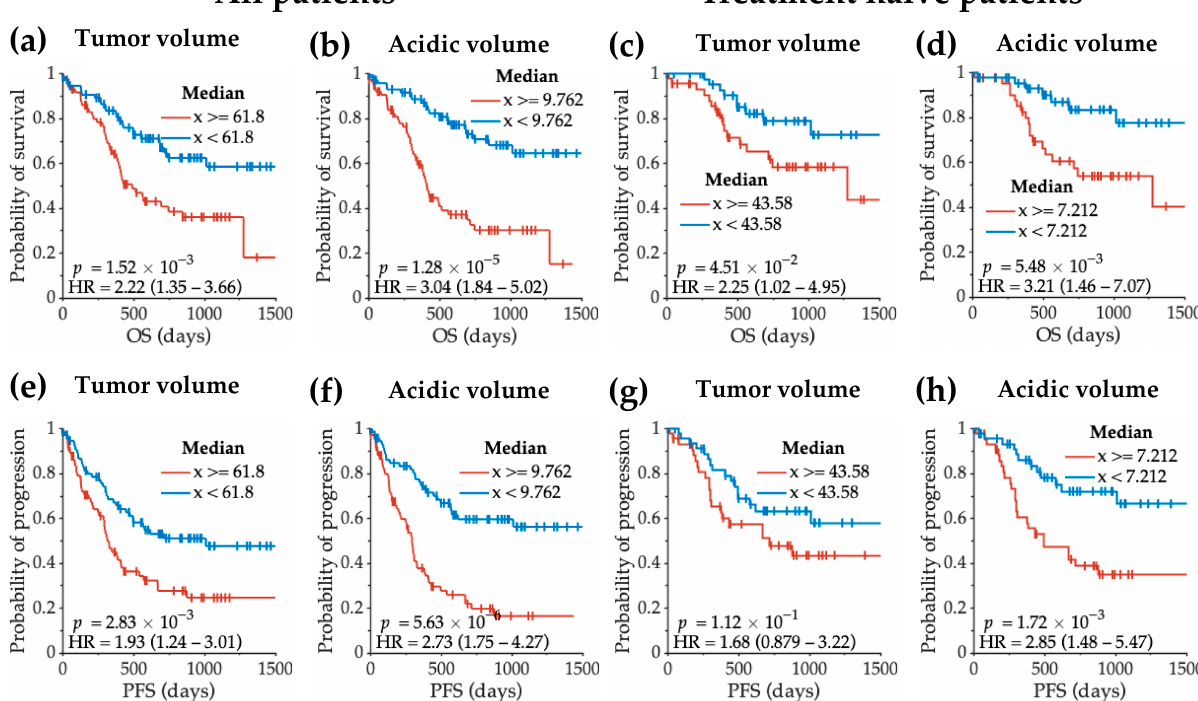
Figure 8. Log-rank analyses of residual overall survival (OS) and residual progression-free survival (PFS) with tumor volume and acidic volume. The log-rank comparisons of OS between low and high tumor volume are plotted in ( a , c ), in the entire patient cohort and in treatment-naïve patients only, respectively. Similarly, the log-rank comparisons of OS between low and high acidic tumor volume are plotted in ( b , d ). ( e – h ) demonstrate the log-rank comparisons of PFS. The OS refers to the residual OS from patient scan date to the date of death. The PFS refers to the residual PFS from patient scan date to the date of disease recurrence .